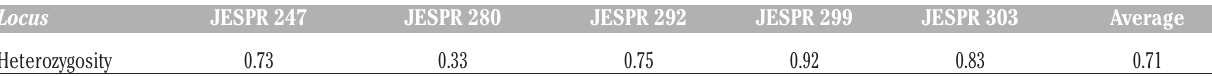
Table 4. The value of heterozygosity at each microsatellite locus in the superior cotton varieties.